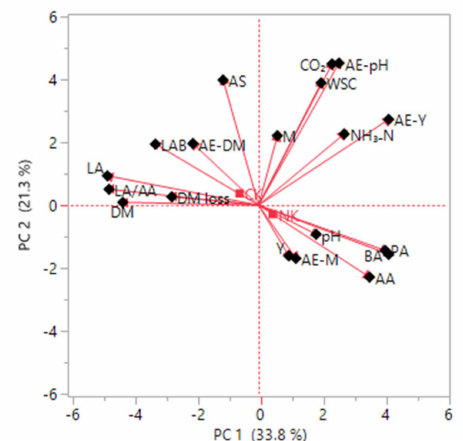
variability of original variables (Table 2). Loading vectors associated with the original variables, with eigenvalues higher than 1, are reported and used to interpret the meanings of 5 retained PCs. Biplot ordering using PCA of alfalfa silage characteristics inoculated with different kefir sources is also presented in Figure 4.